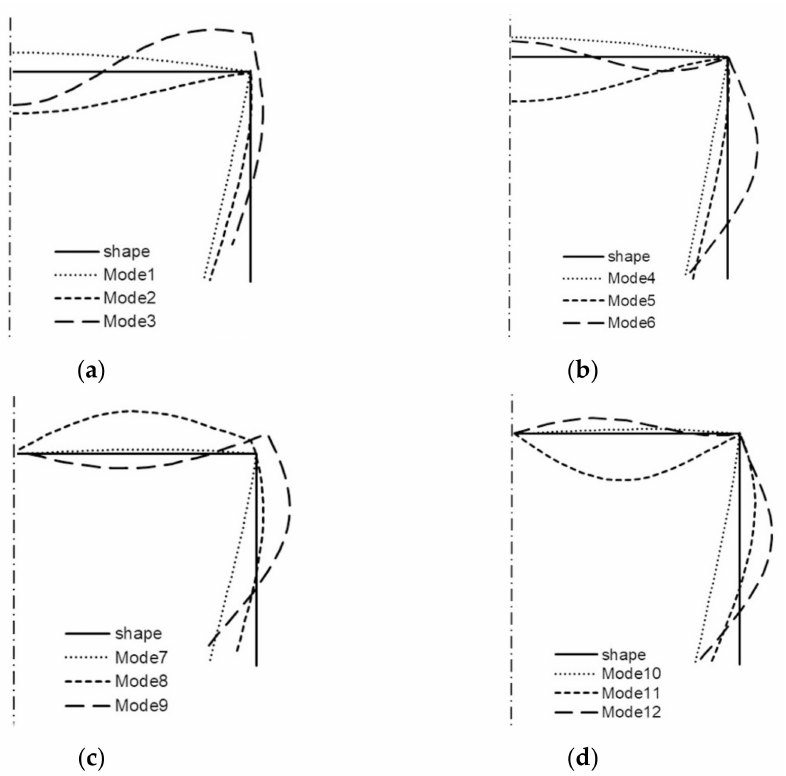
Figure 6. Buckling modes of the channel of the total length L = 210 mm (Table 1): symmetrical modes 1, 2, 3 ( a ), modes 4, 5, 6 ( b ), and anti-symmetrical modes 7, 8, 9 ( c ), modes 10, 11, 12 ( d ).